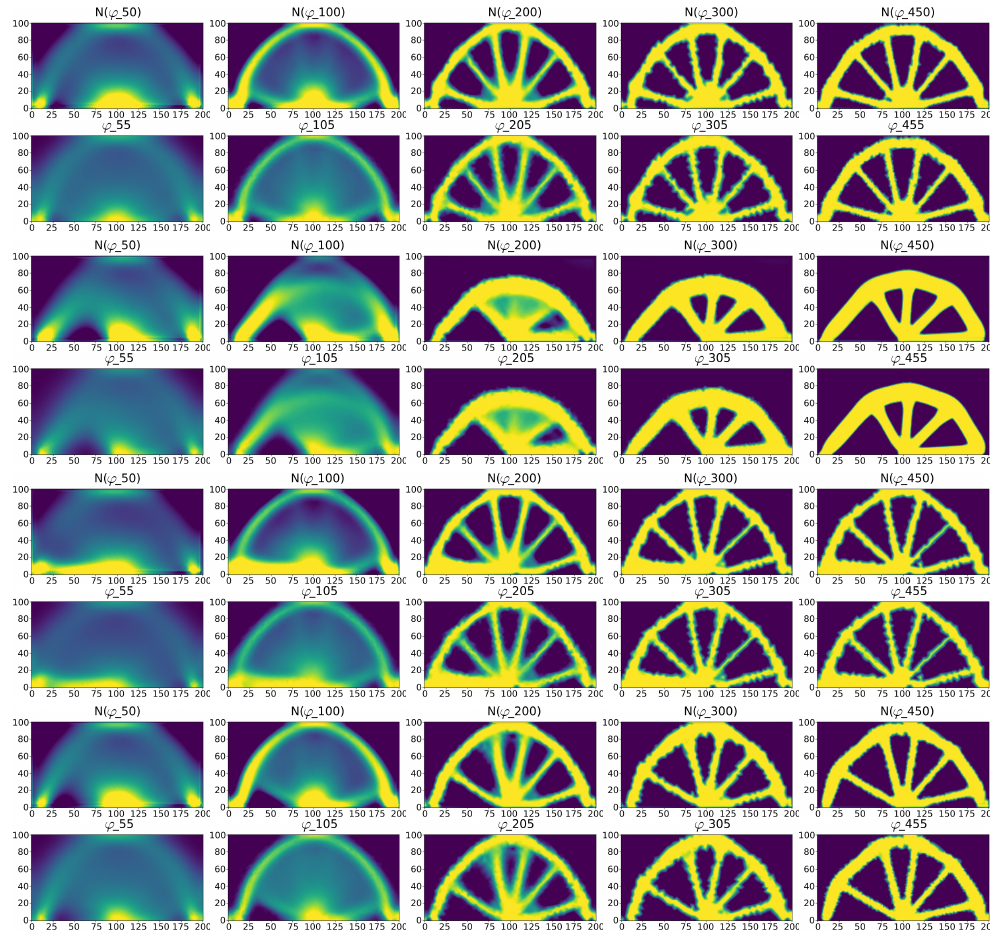
( ϕ n , u ) ( top row ) in comparison with ϕ Figure 4. N 5 n + 1 ; θ CNN